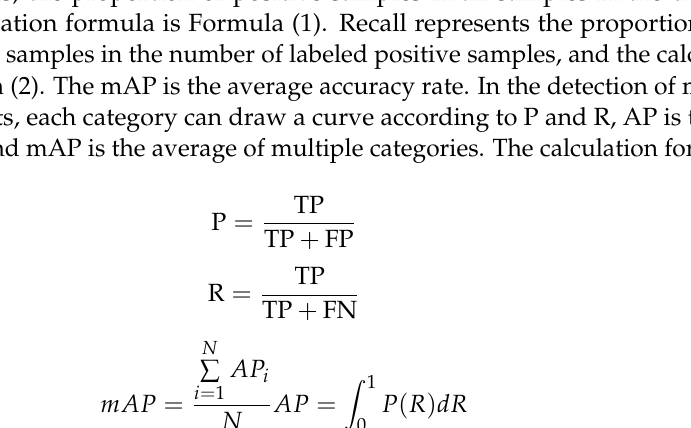
Table 2. Experimental environment.